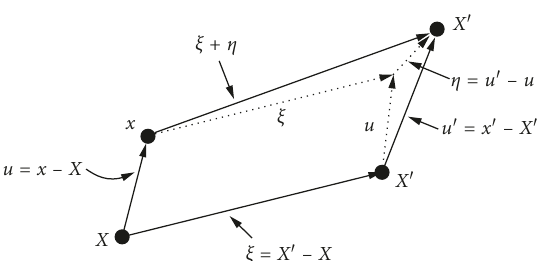
Figure 1: Schematic of motion of peridynamic material